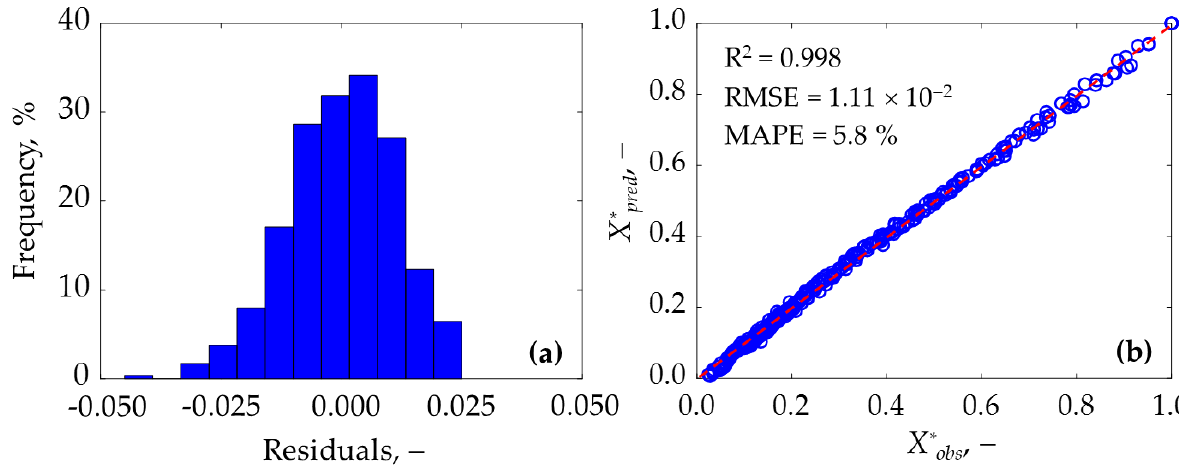
Figure 4. ( a ) Frequency distribution of residuals; ( b ) observed moisture ratio X* obs vs. predicted X* pred for all sets of drying conditions.